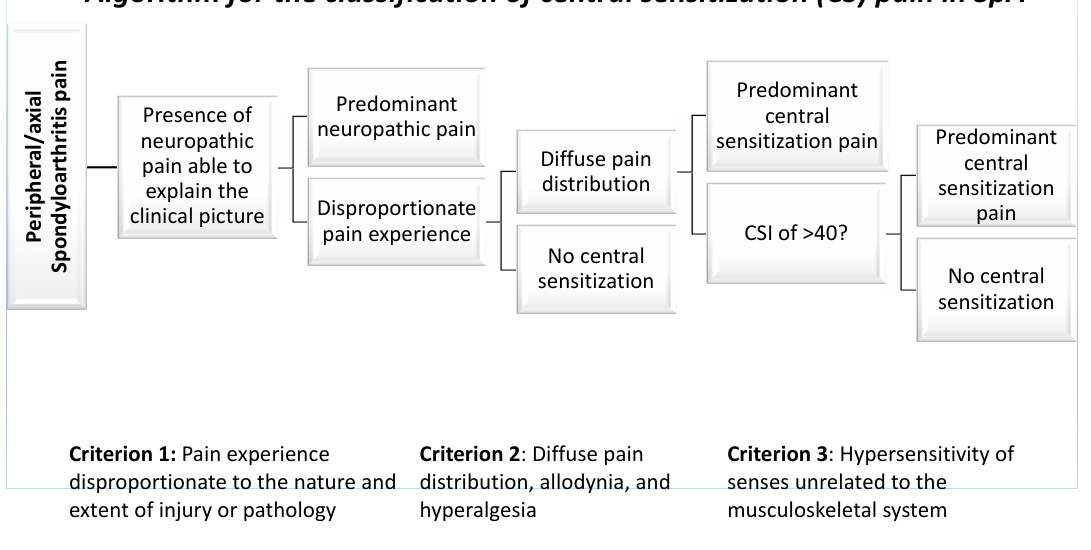
Figure 1. The classification of central sensitization (CS) pain requires two major steps: the exclusion of neuropathic pain and the differential classification of nociceptive versus central sensitization pain. The algorithm for CS pain categorization in SpA is described here.